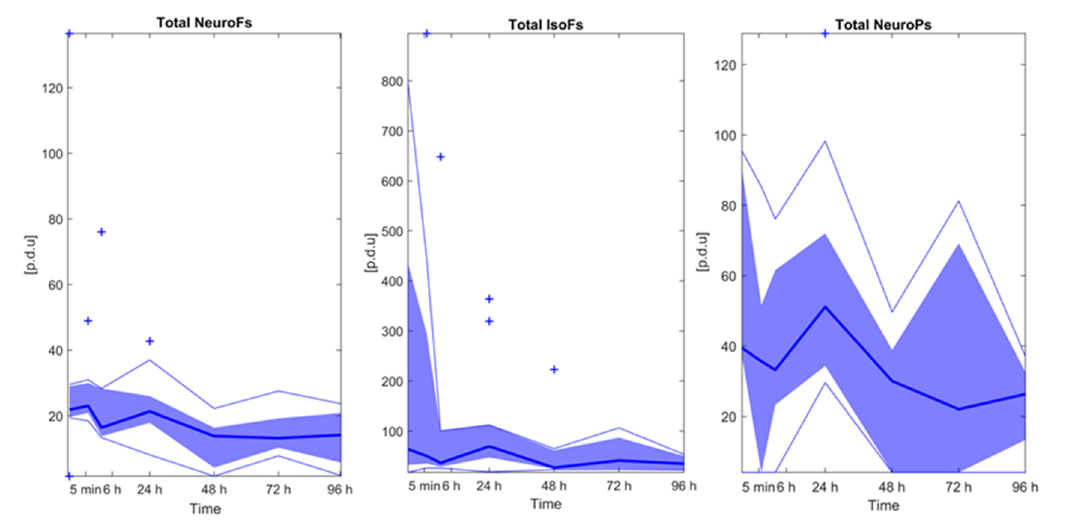
Figure 2. Isoprostanoid levels over time. Note: Bold blue lines correspond to median values, blue areas correspond to the interquartile range (1st and 3rd quartile), thin blue lines correspond to minimum and maximum values, and + correspond to outliers. Note: NeuroFs = neurofurans; IsoFs = isofurans; NeuroPs =